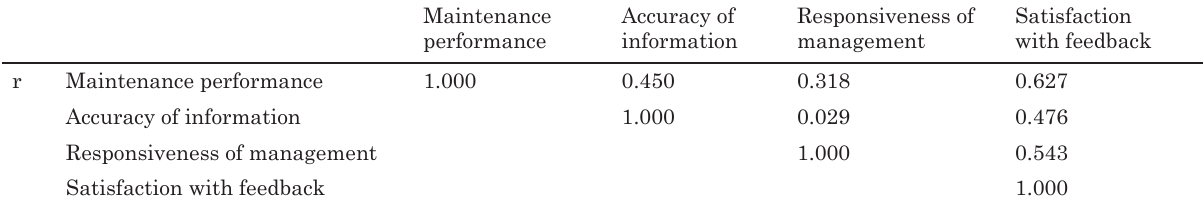
Table 5. Correlation matrix